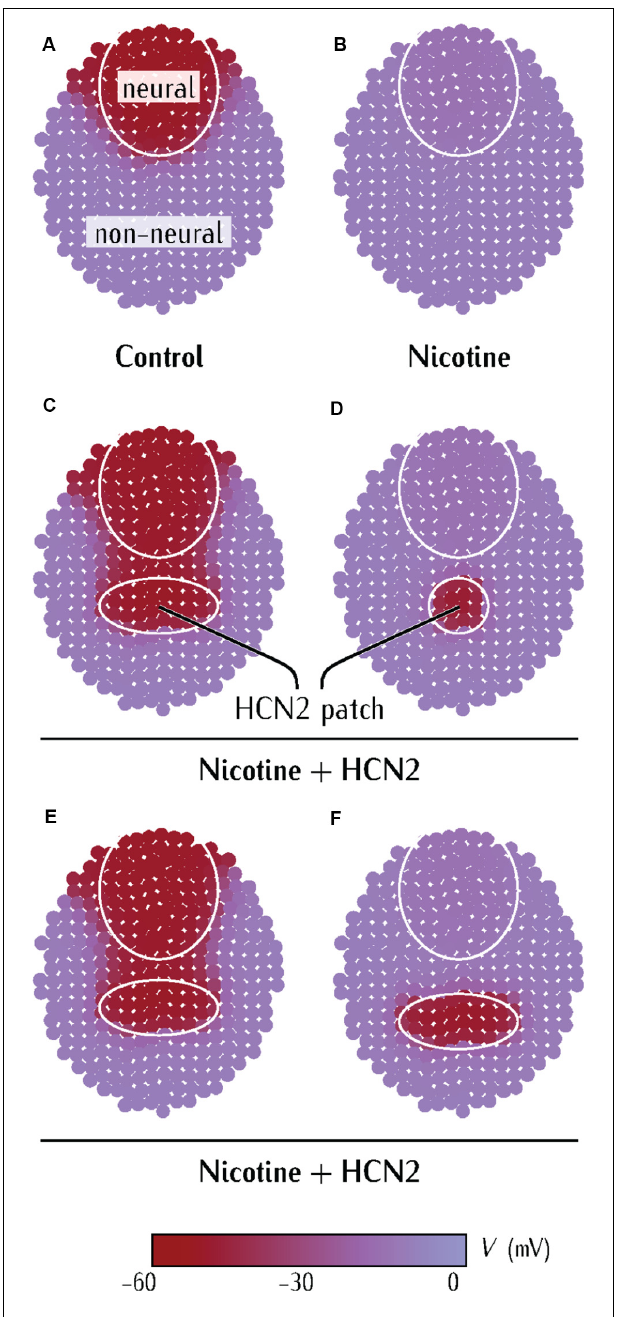
FIGURE 5 | Model predicts limiting conditions for distant (non-CNS) HCN2 channel-mediated rescue of membrane voltage prepattern in nicotine-exposed embryos. (A–F) Simulations from a physiological model of neurulating Xenopus embryo as detailed in Supplementary Figures S1 – S3 . Maroon color represents the region of polarized membrane voltage. Purple color represents the region of depolarized membrane voltage. The pattern in (A) is analogous to the membrane voltage pattern seen in Xenopus embryos with voltage reporter dyes (Pai et al., 2015b). bioelectric influence propagation; it explains the ability of HCN2 expression in remote regions to influence the membrane voltage of anterior neural tissues ( Figure 4